Question: Describe this figure in one sentence.
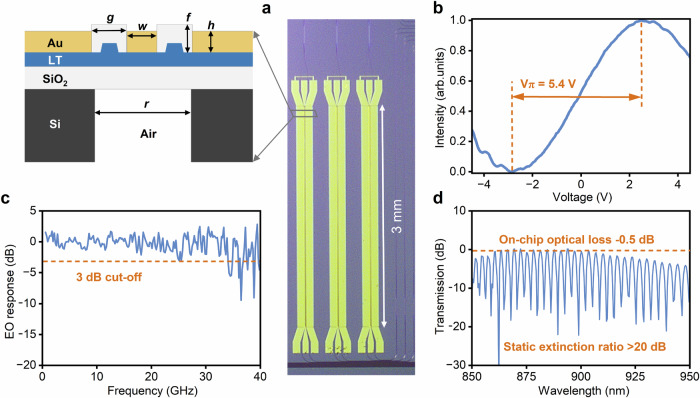
Answer: Room-temperature electro-optic characterization. a Schematic of the LTOI MZI with a coplanar waveguide traveling-wave electrode. Cross-sectional view of the MZI showing the key parameters: g g (electrode gap), w w (signal electrode width), h h (electrode thickness), f f (oxide cladding thickness), and r r (etching trench width). b Modulation curve showing the half-wave voltage (V π ) measurement. c Electro-optic frequency response showing a 3-dB bandwidth exceeding 40 GHz. d Measured optical transmission spectrum of the MZI device.